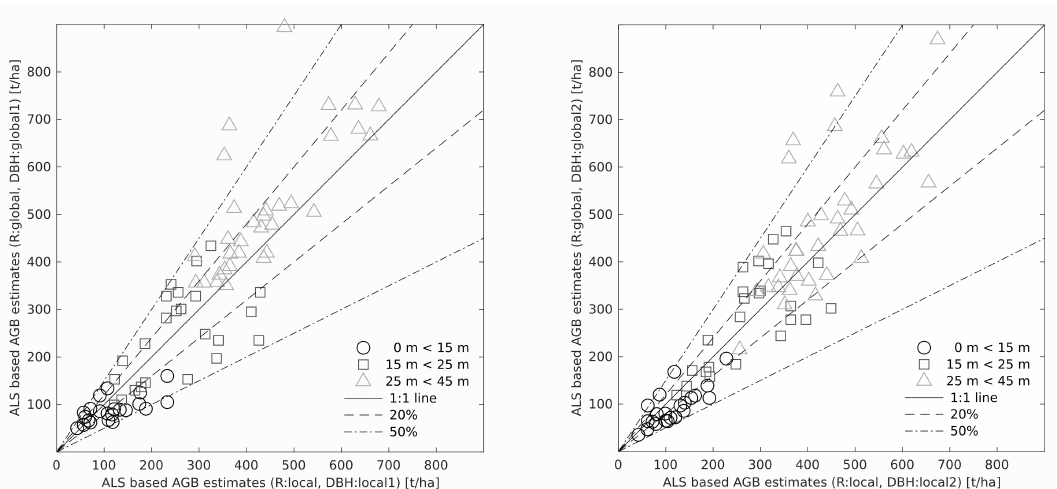
Figure 7. Comparison of AGB estimates at plot level based solely on ALS data. The effect of local vs. global model for DBH estimation is shown: exponential eq. ( left ) and power eq. ( right ). Solid line highlights 1:1 line and the dashed lines indicate 20% and 50% deviation from 1:1 line.